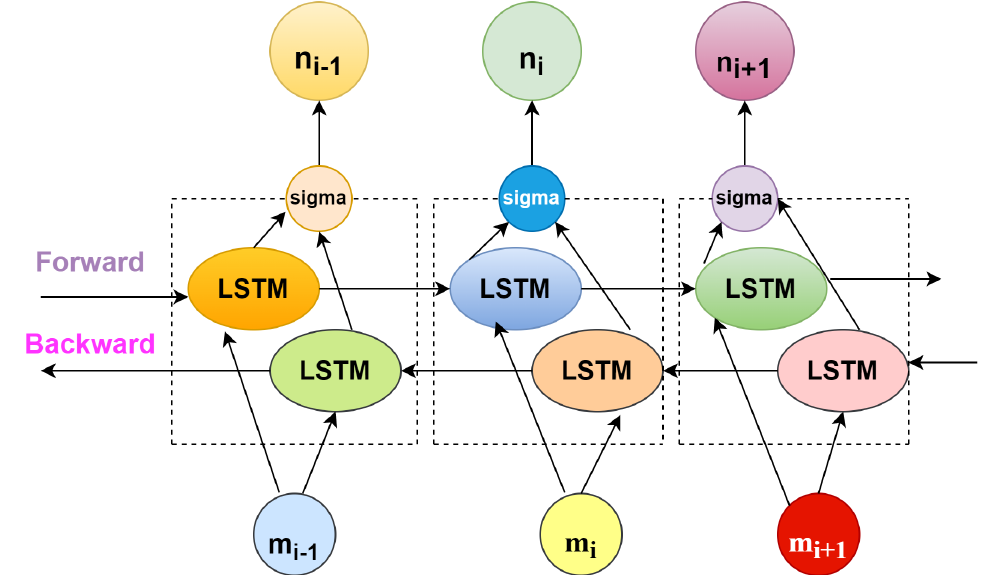
Figure 3. Working of